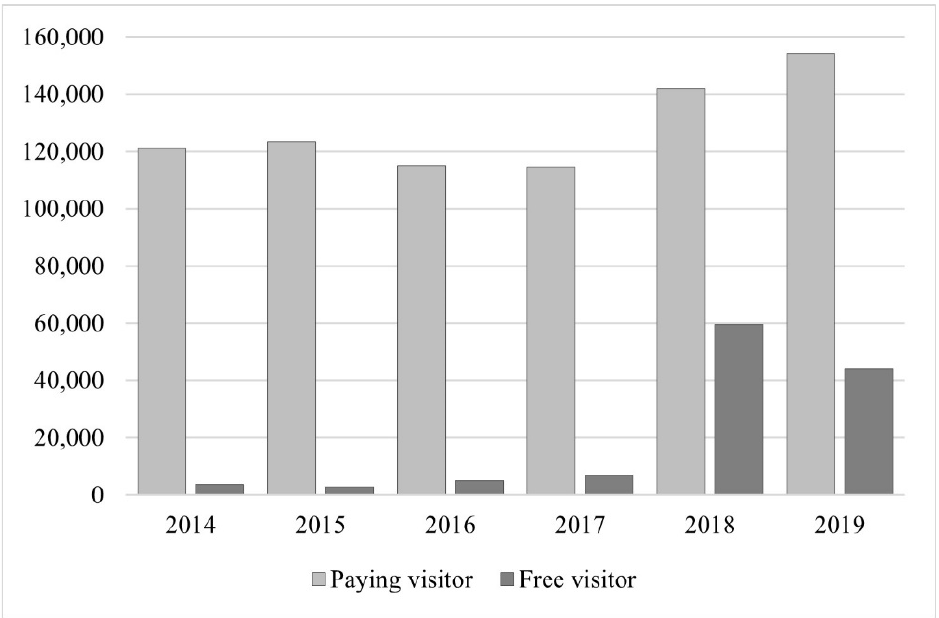
Figure 3. Evolution of the number of visitors of the Benedictine Abbey Church and Museum in Tihany between 2014 and 2019, according to visitor type (paying or free). Source: Own compilation.